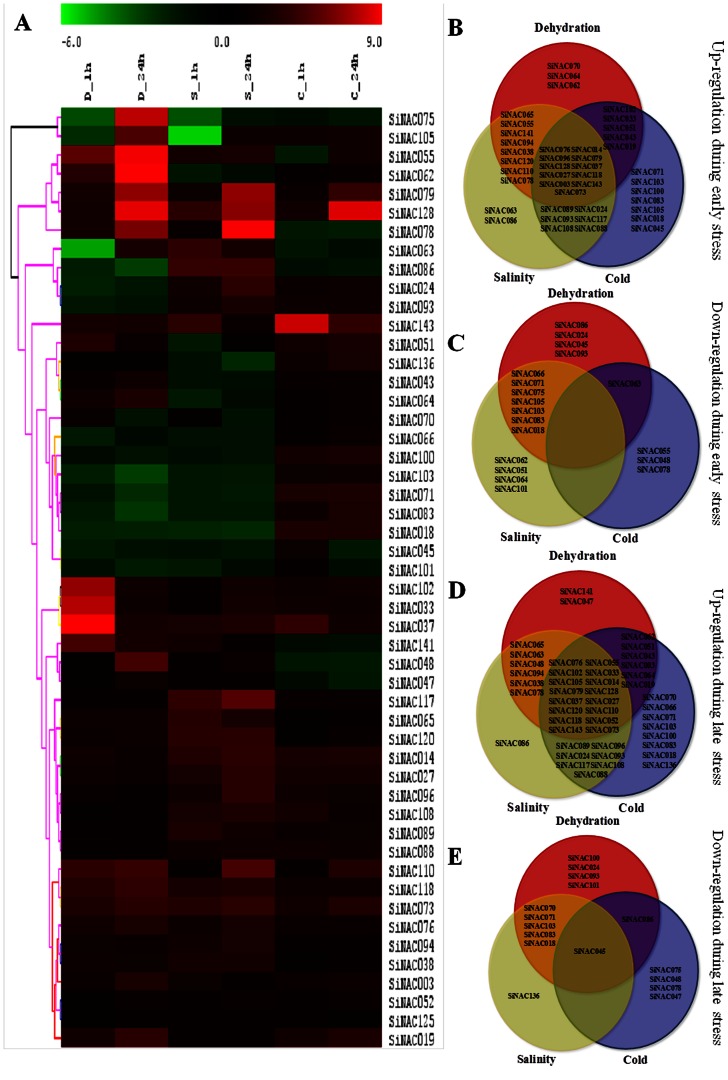
Expression profile of 50 foxtail millet NAC genes in response to various abiotic stresses.(A) Hierarchical clustering of differential gene expression in response to dehydration (D), salinity (S) and cold (C) stress across two time points (1 h and 24 h). The heat-map has been generated based on the fold-change values in the treated sample when compared with its unstressed control sample. The color scale for fold-change values is shown at the top. Venn diagram showing stress-specific distribution of SiNAC genes into four categories as (B) early up-regulated, (C) early down-regulated (D) late up-regulated, and (E) late down-regulated. The common subset of genes regulated by two or more stresses is marked by the overlapping circle.